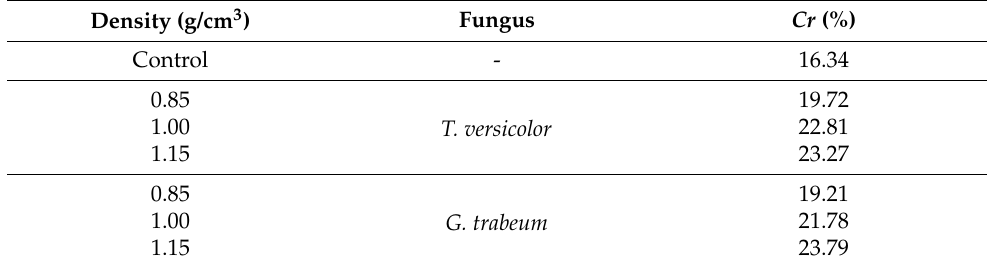
Table 4. Crystallinity ( Cr ) of healthy (control) and decayed OWMECs with different densities. Density (g/cm 3 )